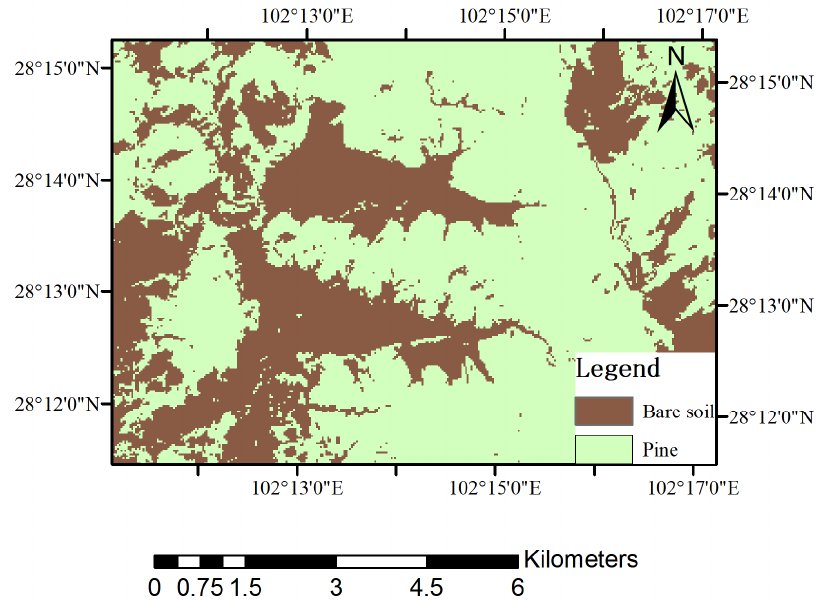
Figure 4. Combustibles distribution map.